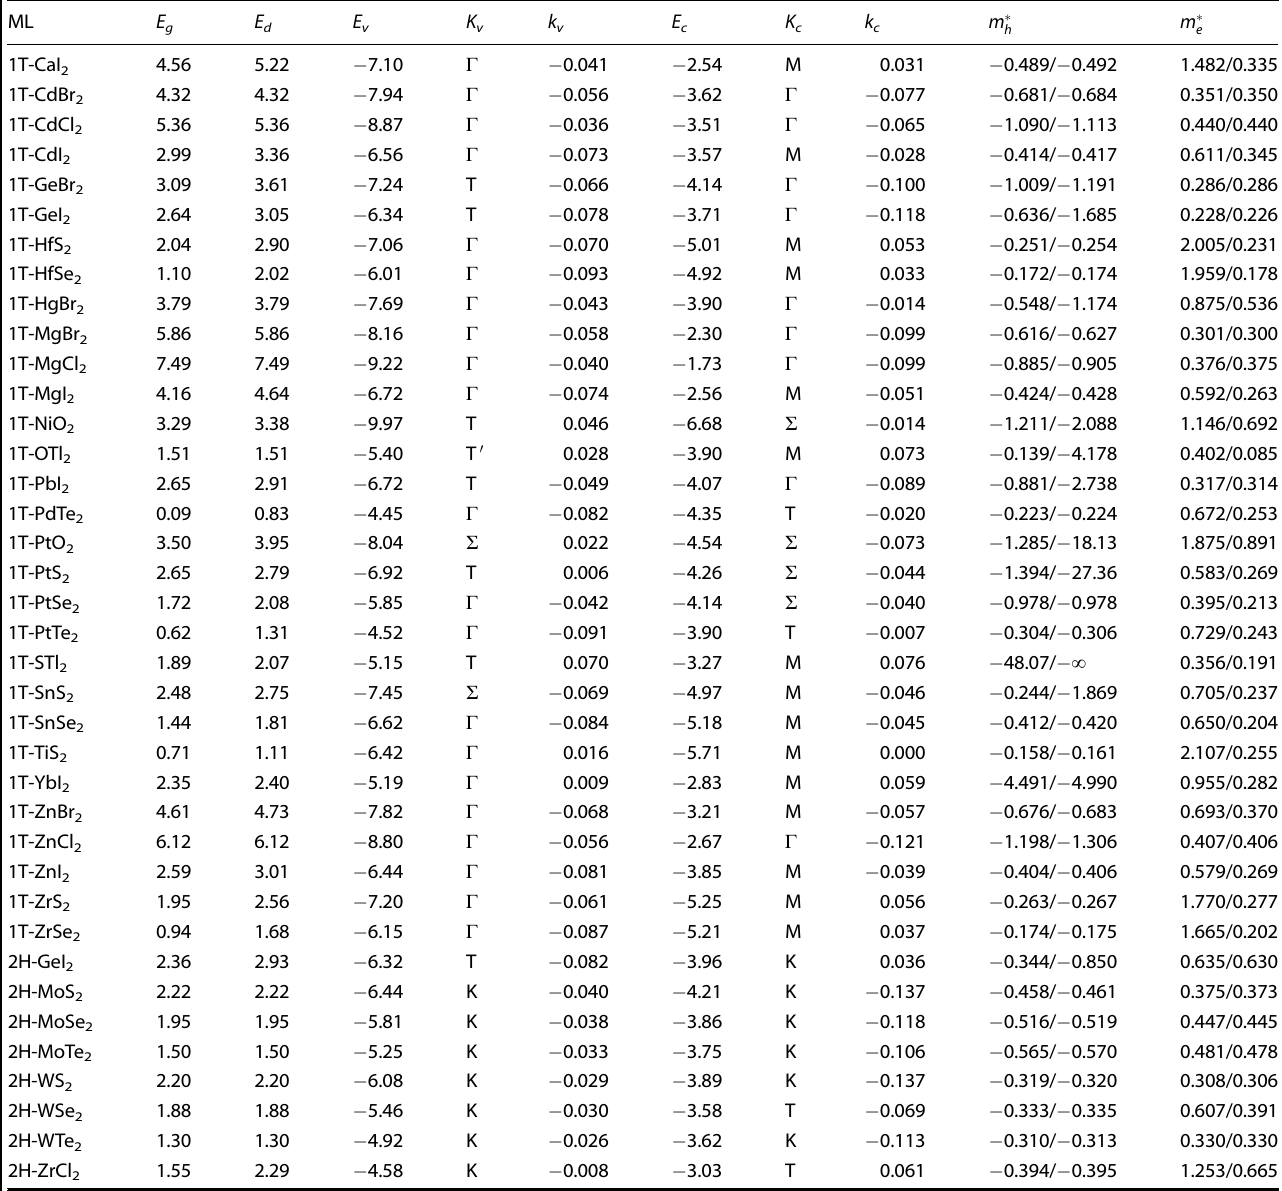
Table 2. Electronic properties of 38 nonmetallic and nonmagnetic